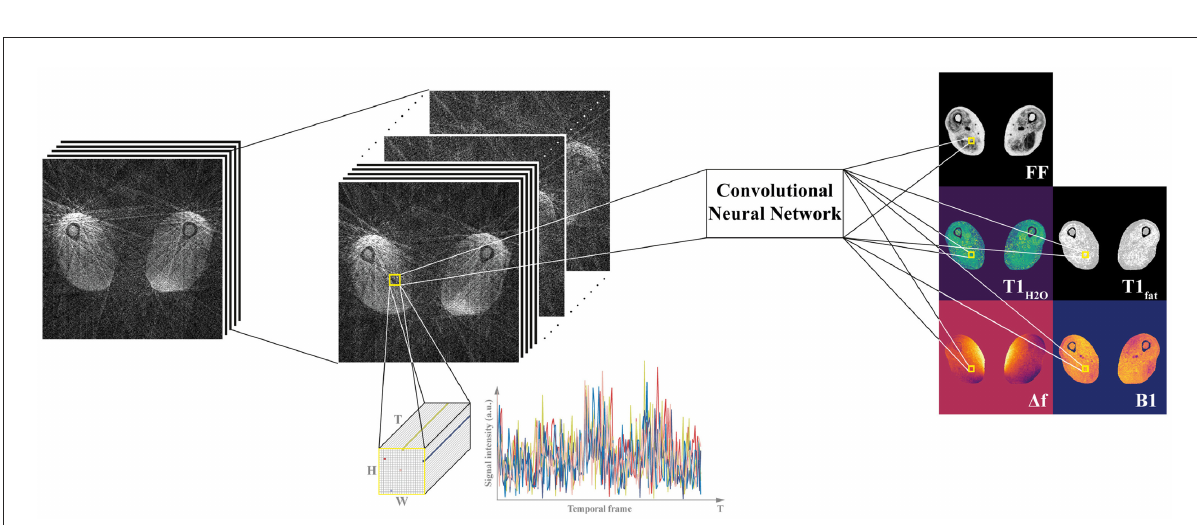
FIGURE5 Spatially-regularized convolutional neural network from Balsiger et al. (90). In addition to the temporal information from each fingerprint, for each voxel a HxWxT patch of undersampled image data is used to calculate the parameter maps [in their work, Balsiger et al. (90) employ a patch size of H = W = 15]. The network achieves improved accuracy by incorporating spatial regularization in the map generation process from undersampled image